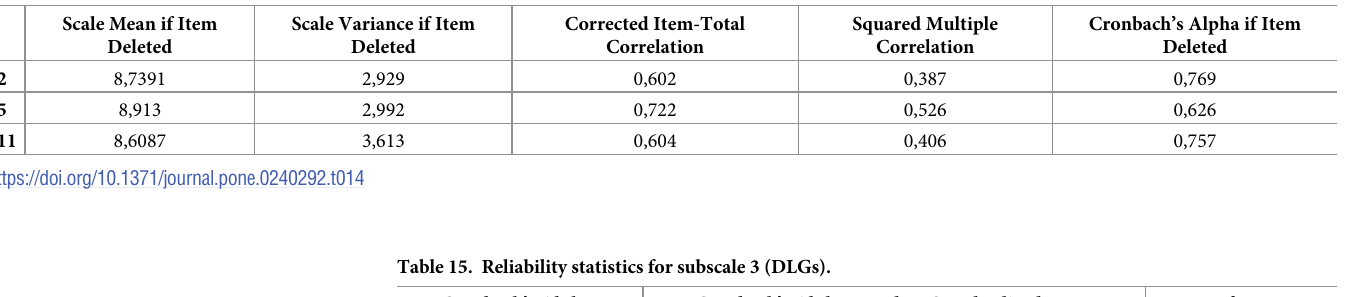
Table 14. Item-total statistics for subscale 2 (IGs).